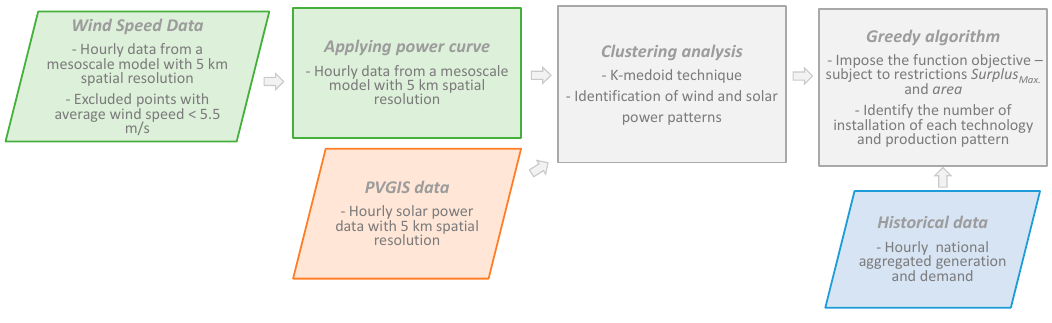
Figure 1. Schematic flowchart of the methodology applied in this work.